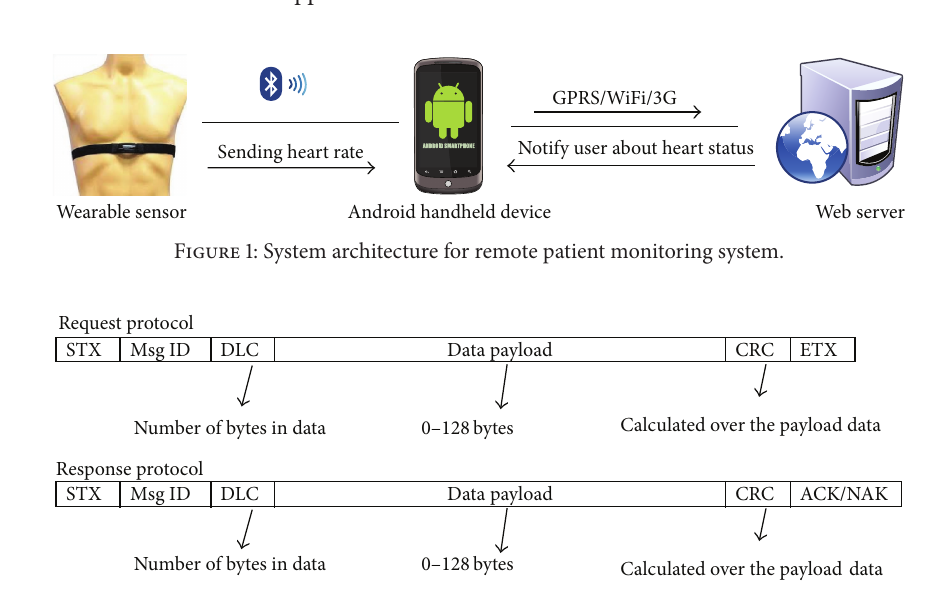
Figure 2: Message format for